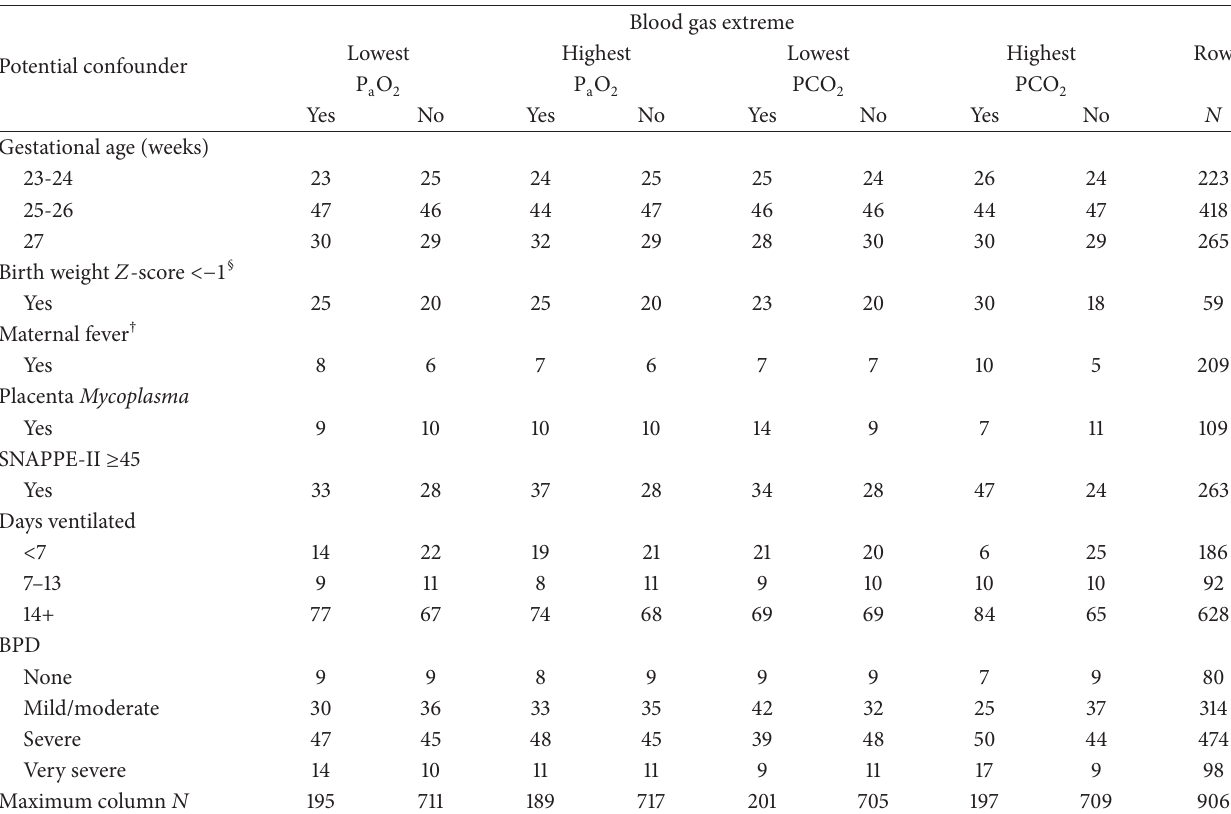
Table 2: The distribution of infants who had a blood gas extreme (defined as a P age on at least two of the first three postnatal days) listed at the top of each column within strata of potential confounders, listed on the left. These are column